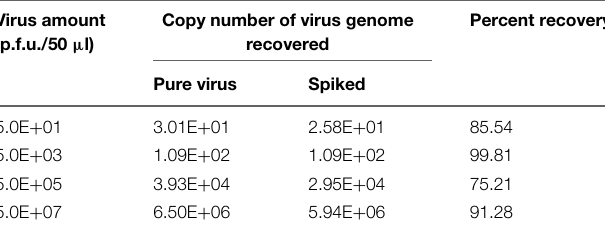
TABLE 1 | Efficiency of recovery of BAd- (cid:2) E1E3 virus from PUF. Virus amount (p.f.u./50 µ